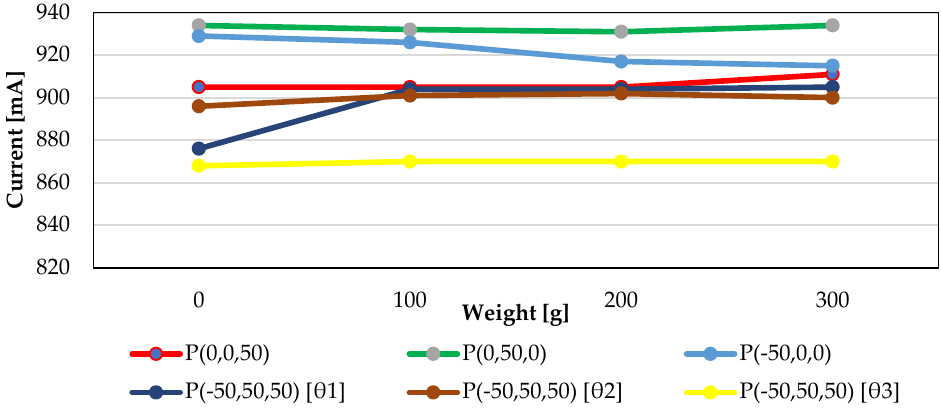
Figure 17. Current result as a function of weight obtained during test no. 4.